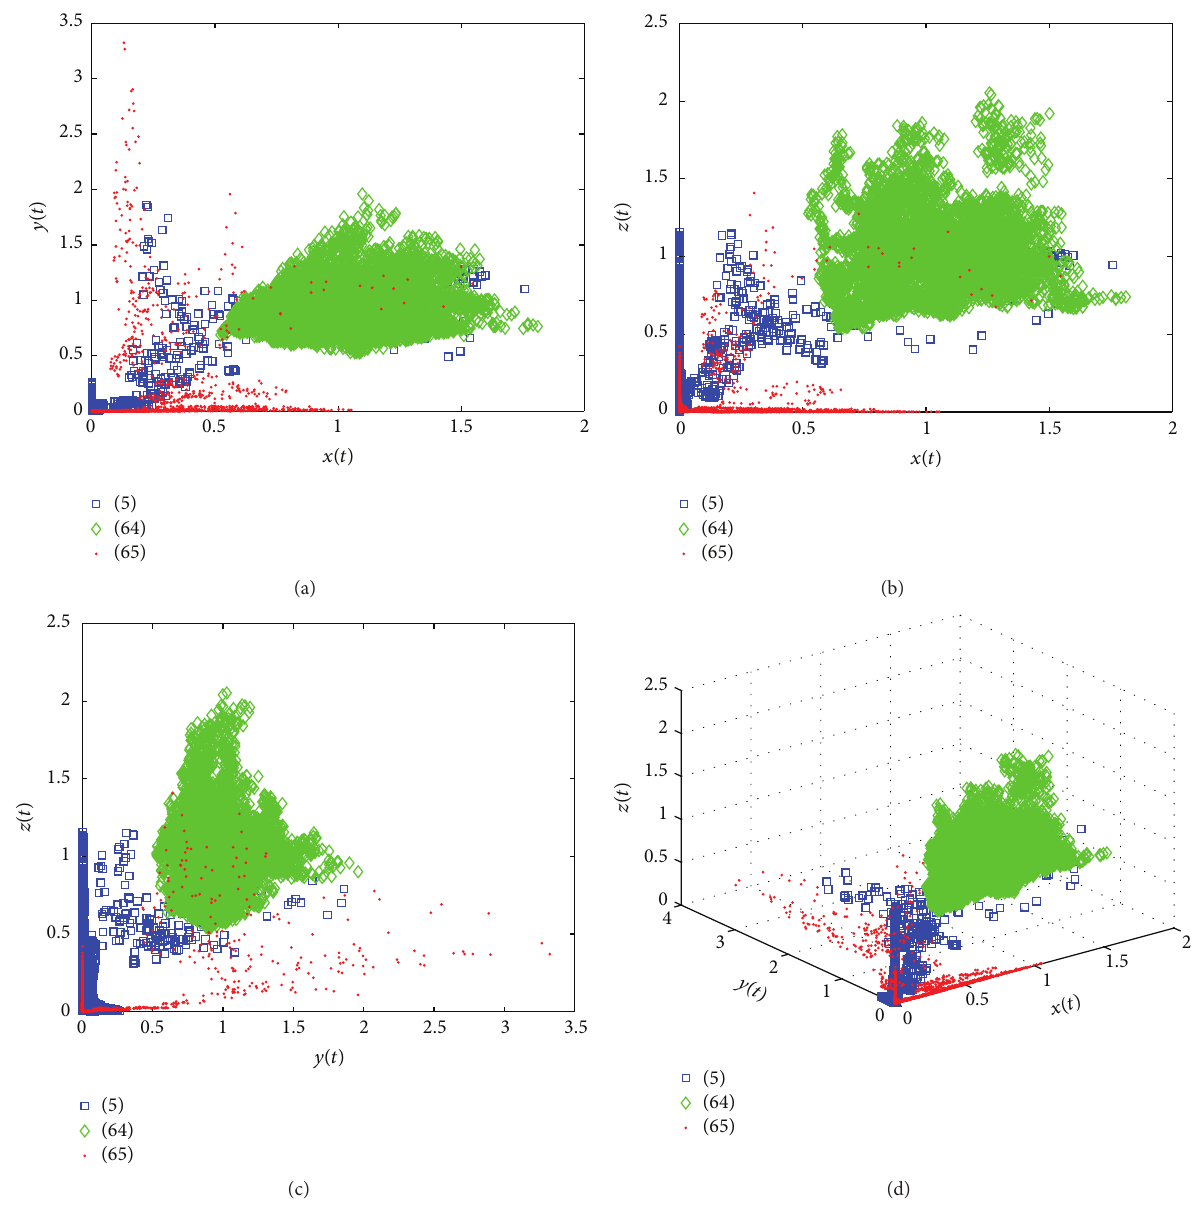
Figure 8: The above subgraphs have the same notations as in Figure 5. Under the control of Markov chain, most points of the blue area lie in the origin and mean extinction in Case 2 of Example